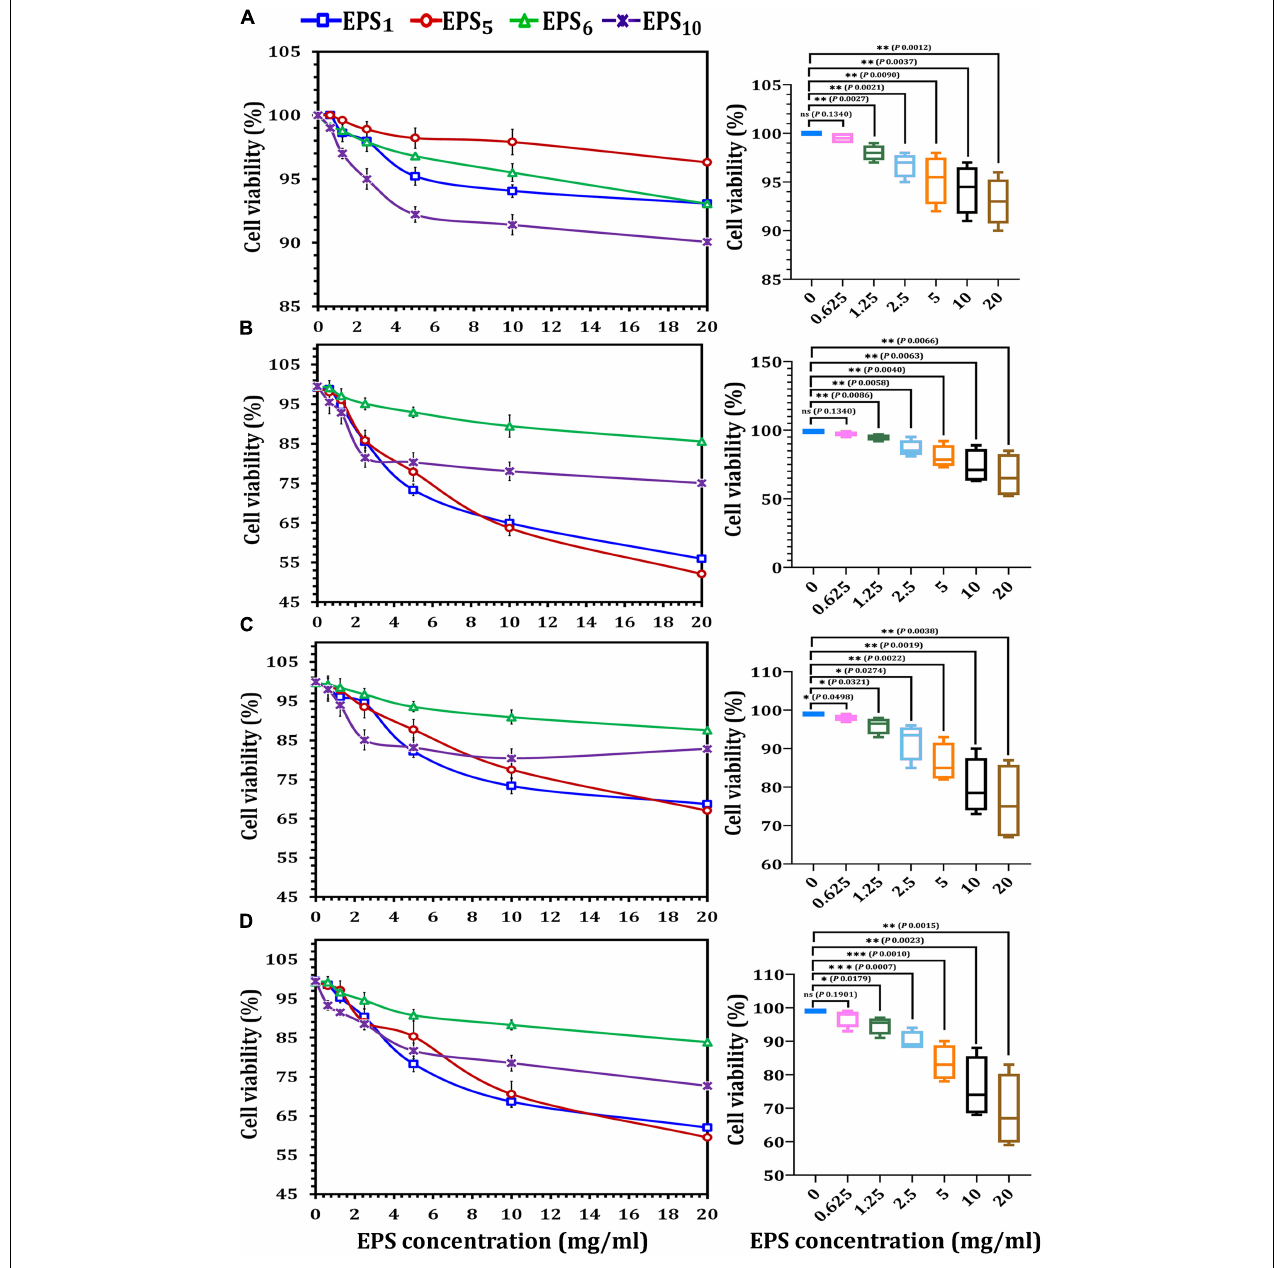
Figure 2 | Cytotoxicity assessments of exopolysaccharides on different cancer cell lines using MTT assay. (A) On HEK293 cell line, (B) on MCF7 cell line, (C) on CaCo2 cell line, and (D) on HepG2 cell line. EPS 1 , EPS derived from S. thermophilus DSM 24731; EPS 5 , EPS derived from L. delbrueckii ssp. bulgaricus DSMZ 20081 T ; EPS 6 , EPS extracted from L. fermentum DSMZ 20049, and EPS 10 , EPS derived from B. longum ssp. longum DSMZ